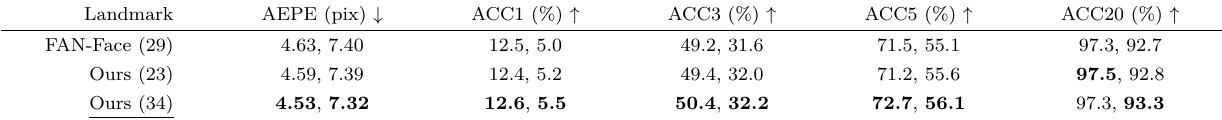
Table 3 Results using different facial landmarks. Results for the Synthetic Face and FaceFlowData datasets, are separated by commas. Numbers in the first column give the number of facial landmarks used. Best results are highlighted in bold; settings used in our final model are underlined